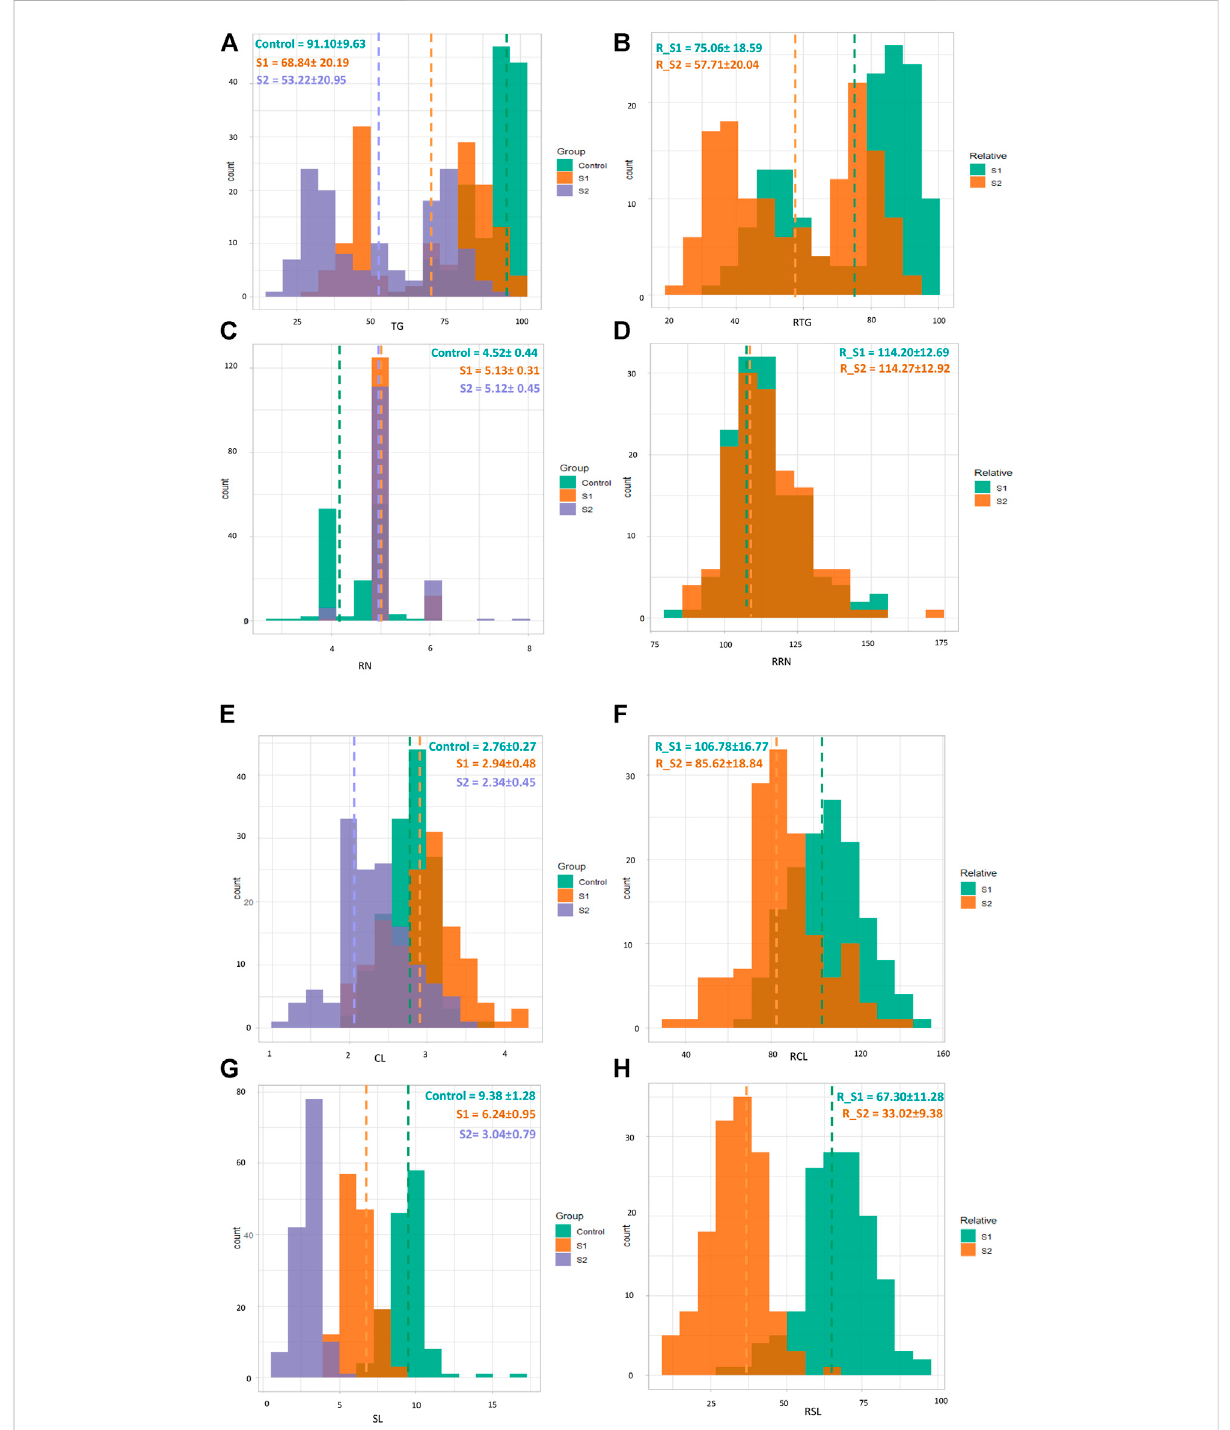
FIGURE 1 Overlaid histograms showing frequency distributions of TG (A) , RTG (relative) (B) , RN (C) , RRN (relative) (D) , CL (E) RCL (relative) (F) , SL (G) , RSL (relative) (H) , RL (I) , RRL (relative) (J) , R/S (K) , RR/S (relative) (L) , SVI (M) , and RSVI (relative) (N) across control (green), S1 (brown), and S2 (purple, for relative traits S1 (green) and S2 (brown). The vertical dotted lines indicate the mean values of each